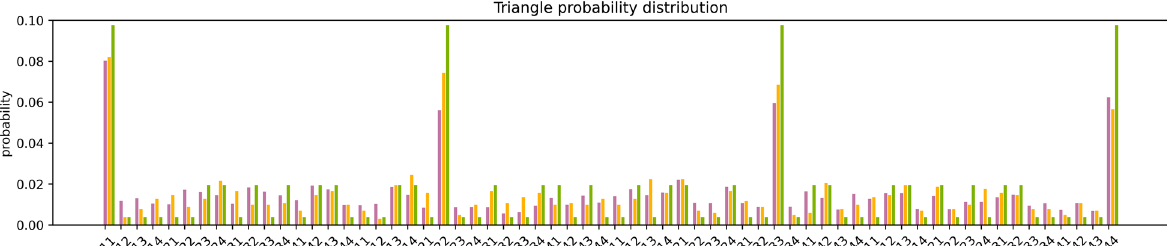
Fig. 4 Triangle network results. Histogram of the probability distribution of the quantum triangle network. The green distribution corresponds to the theoretical prediction, while the purple and orange correspond to the outcomes of experiments conducted on the ibmq_montreal device and the ibmq_johannesburg device,